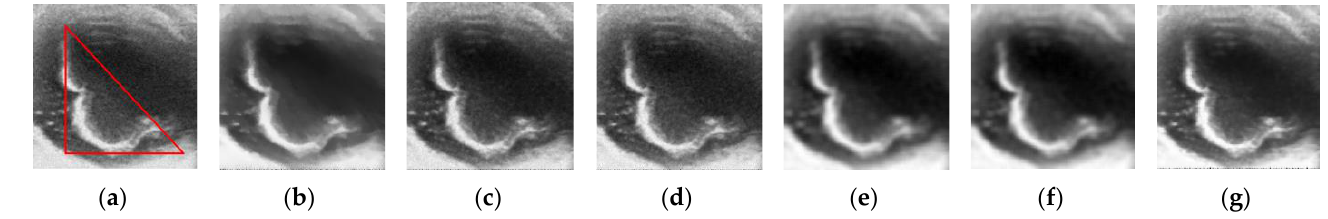
Figure 9. Denoising results of different models after adding Gaussian noise with a standard deviation of 15 to vitreous mechanization images. ( a ) Noise image, the red marked area is the part of the lesion. ( b ) TV model, run 0.4956 s. ( c ) FTV model, run 0.9436 s. ( d ) AFOTV model, run 0.5095 s. ( e )